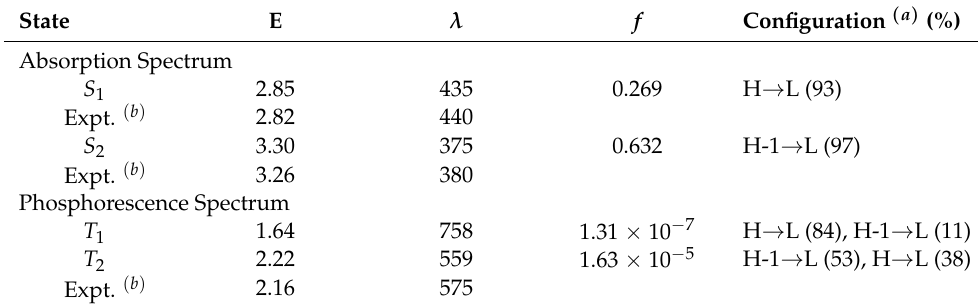
Table 2. Excitation energy (in eV), wavelength (in nm), and oscillator strength of S-BF2 in CH 2 Cl 2 solution. State E λ Configuration ( a ) (%)